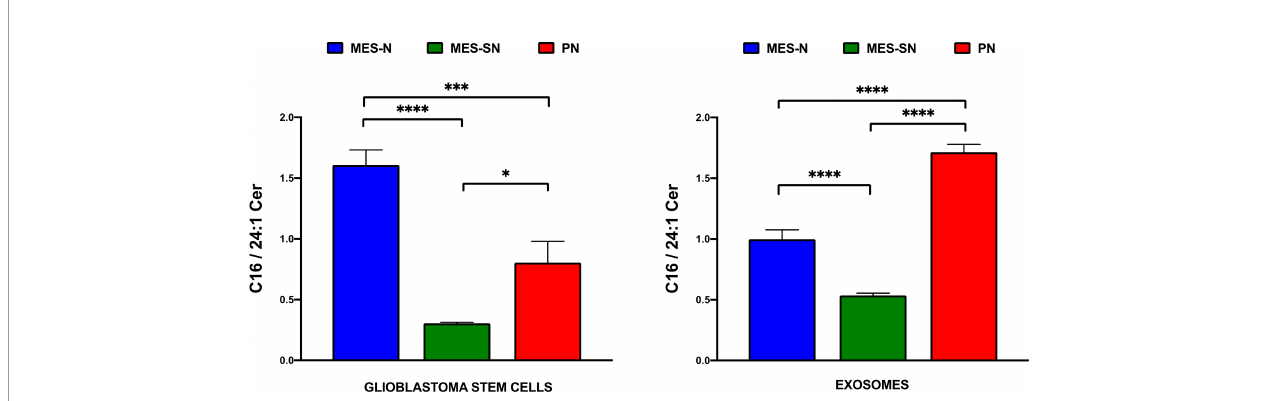
FIGURE 6 | C16/C24:1 Cer ratio in GSCs and their cell-derived exosomes. In blue, MES-SN phenotype; in green, MES-N phenotype; and in red, PN phenotype. For all bar graphs, error bars represent mean ± SEM. *p < 0.05; ***p < 0.001; and ****p <